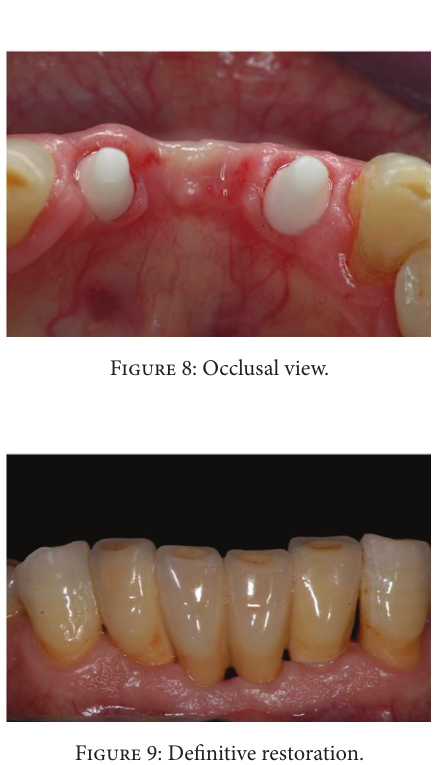
Figure 9: Definitive restoration.